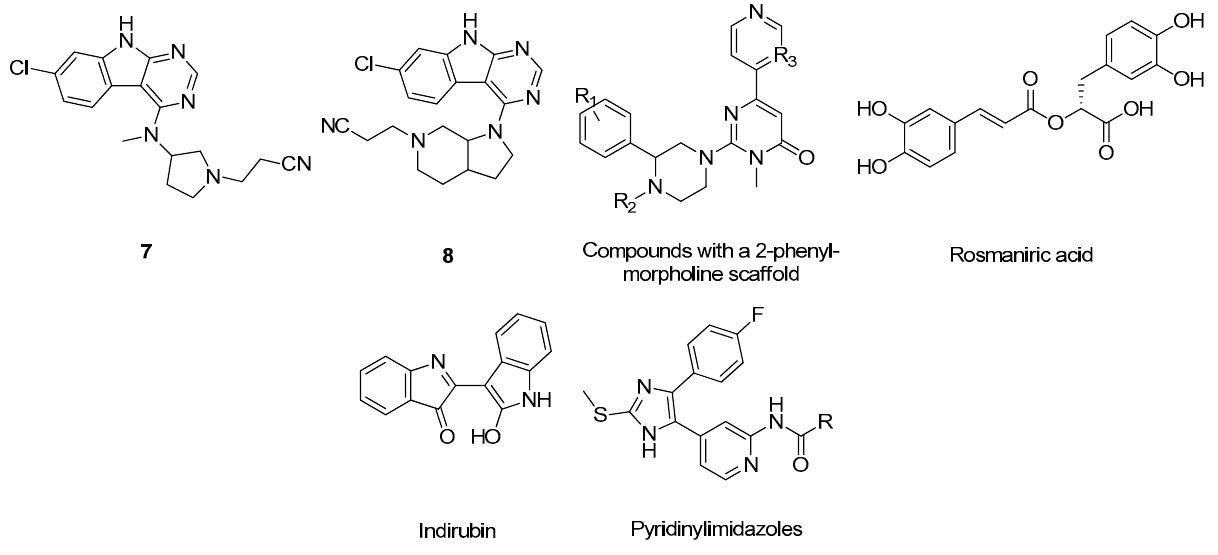
Figure 12. Structure of the studied GSK-3 inhibitors. On the other hand, Lozinskaya and co-workers studied the affinity of oxindole deriva- tives by molecular docking but targeting the ATP-binding site of GSK-3 (PDB#4J1R) to identify potential new allosteric GSK-3 inhibitors [90] (Figure 13). Shukla et al. [91] per- formed a four-step virtual screening from sets of 5, 36, and 709 compounds to predict the most potent compounds for further docking against GSK-3 (PDB#1J1B) and ADMET properties analysis. After this, the top 29 compounds were submitted to molecular dy- namics simulations, where compounds ZINC21011059 and ZINC21011066 (Figure 13) were predicted as being the most energetically favorable and with the highest potential